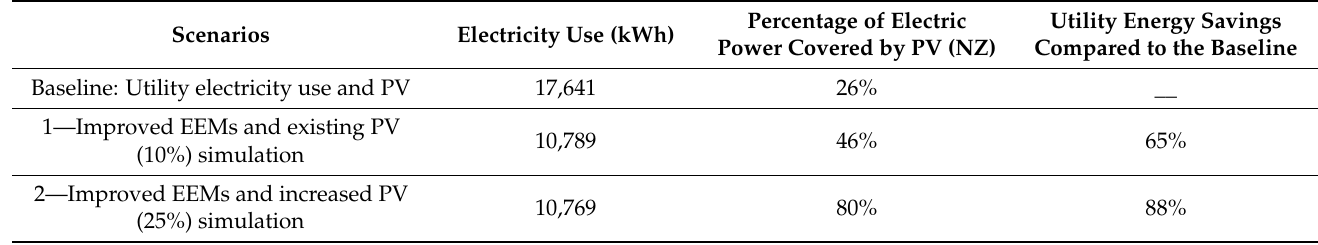
Table 8. Comparative analysis of the measured baseline and two simulated scenarios in building C in